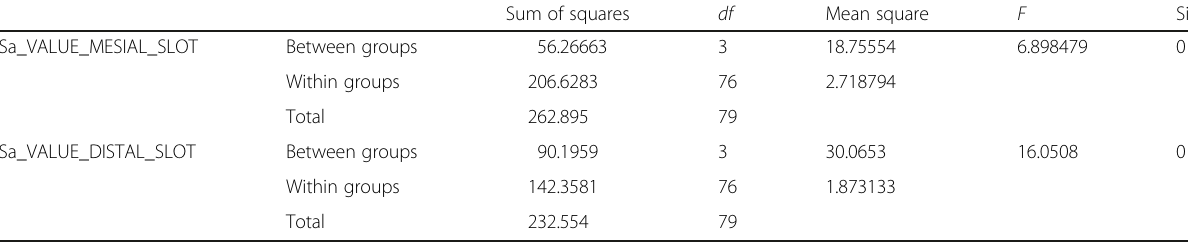
Table 1 One-way ANOVA test for slot surface roughness